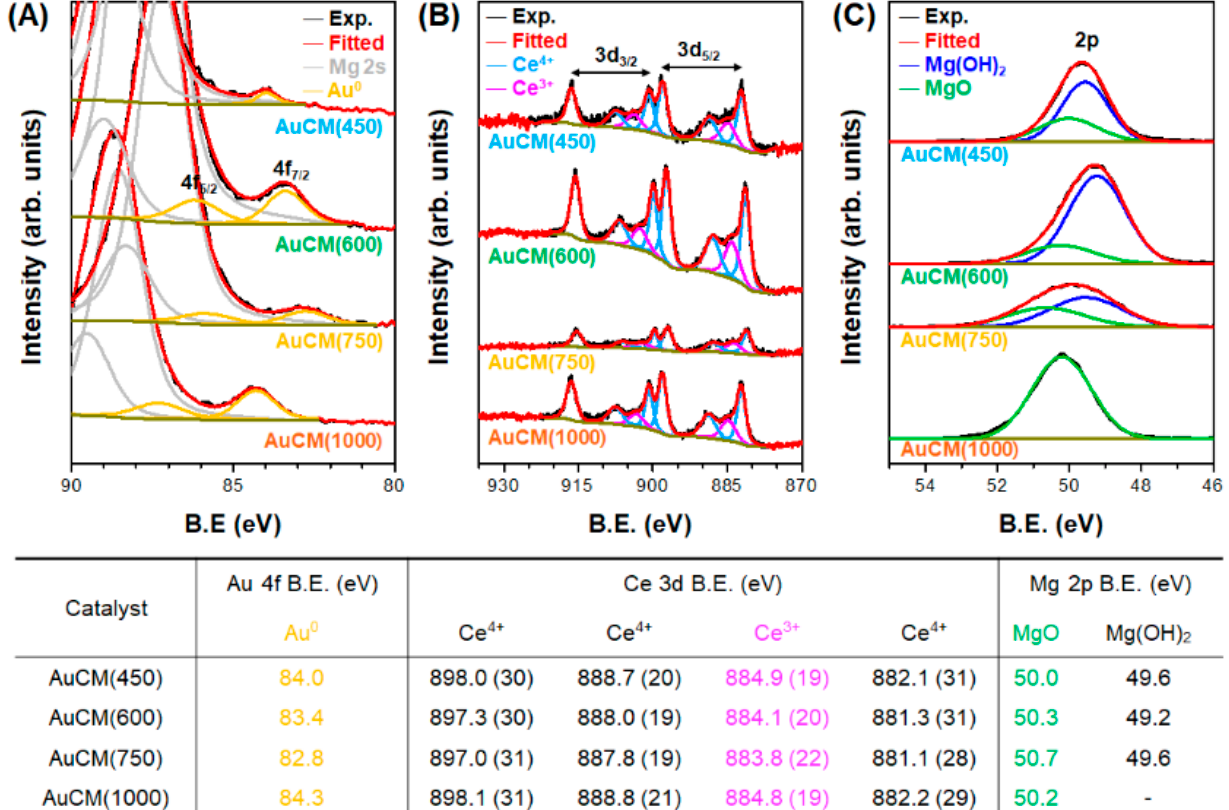
Figure 7. X-ray photoelectron profiles corresponding to the representative binding energy (B.E.) regions of ( A ) Mg 2s, Au 0 , and Au 1+ , ( B ) Ce 4+ and Ce 3+ , and ( C ) Mg(OH) 2 and MgO for the series of AuCM catalysts in which the CeO 2 –Mg(OH) 2 supports were calcined at different temperatures. The table at the bottom summarizes the B.E. values for the representative peaks, and the numbers in parentheses indicate the percentages of elements with different electronic states. The experimental and fitted XPS profiles are drawn in black and red, respectively.